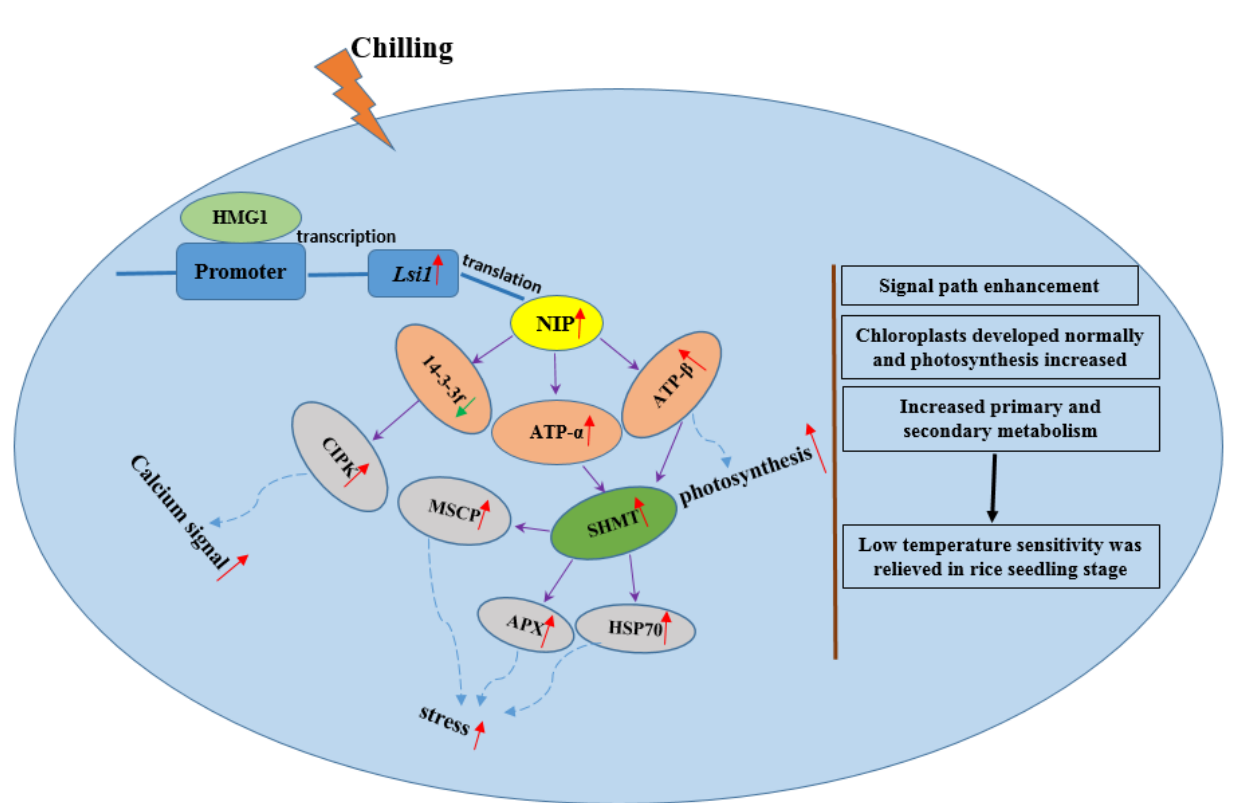
Figure 10. Confirmed protein interaction proteins via Western blot. ( A ) The interaction between the